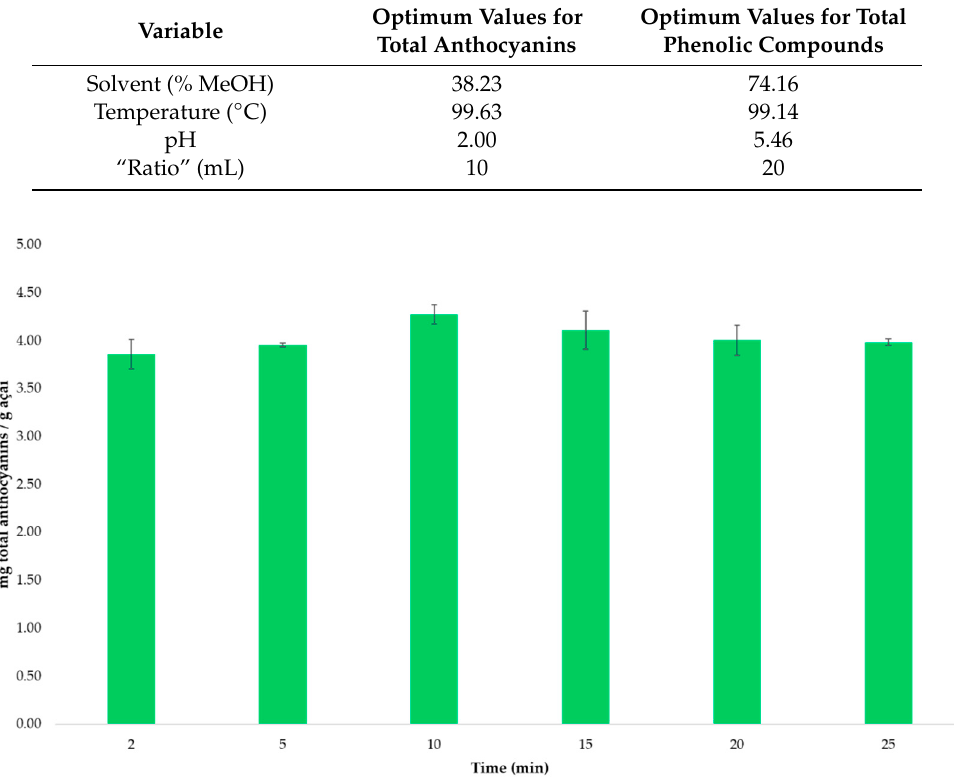
Figure 3. Milligrams of total anthocyanins recovered per gram of açai at different extraction times ( n = 3).